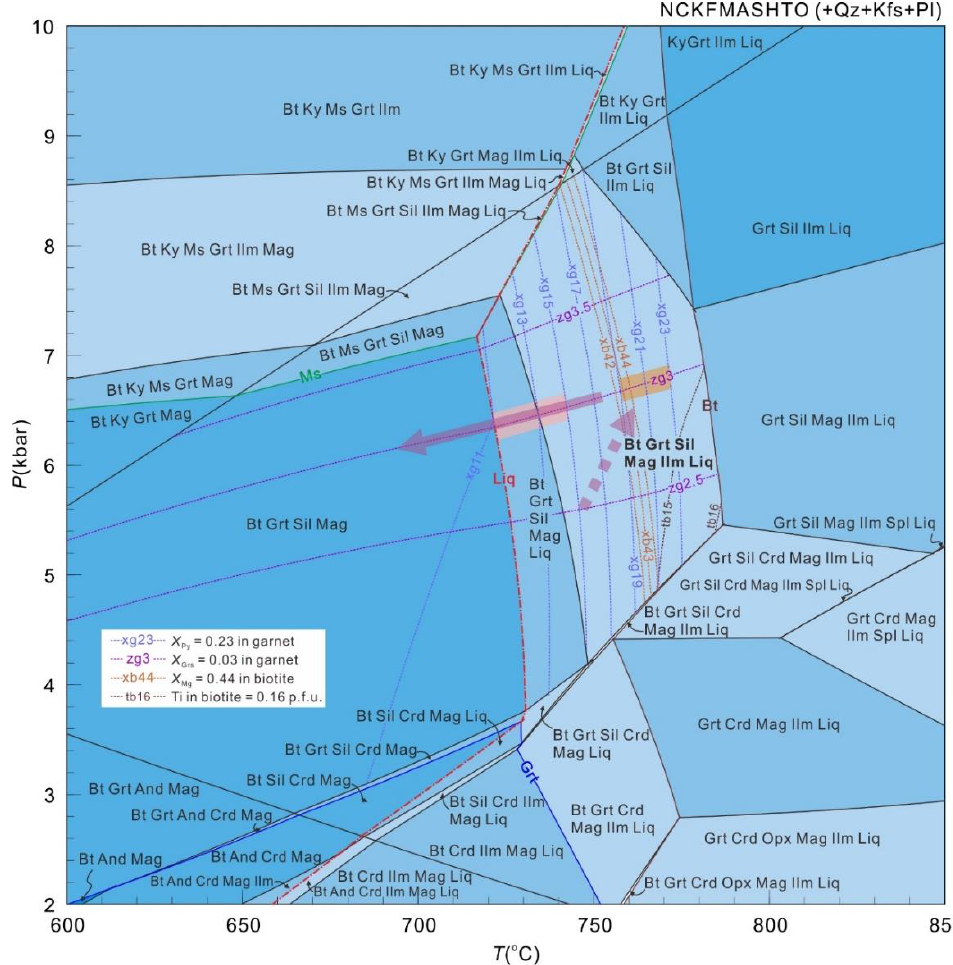
Figure 4. P – T pseudosection with proposed P – T path for sample 15Q-4 in the system NCKFMASHTO with the excess of potassic feldspar, plagioclase and quartz. Mineral abbreviations follow [48].